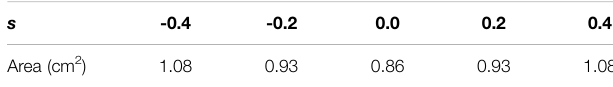
TABLE 2 | Position scale constants for the MVC simulations and resulting MV opening areas at E-wave peak. The MVC is positioned at s · l from the center of thecoaptationline,with l beingthelengthofthelongaxisintheMVmodel.Here s < 0 corresponds toclippositions anterolaterally (i.e.towardthe right edgein Figure 1A ) ofthe center, and s > 0 posteromedially (to the leftin Figure1A ).For reference, the area of the MV opening at mid diastole with no MVC is 2.54 cm 2